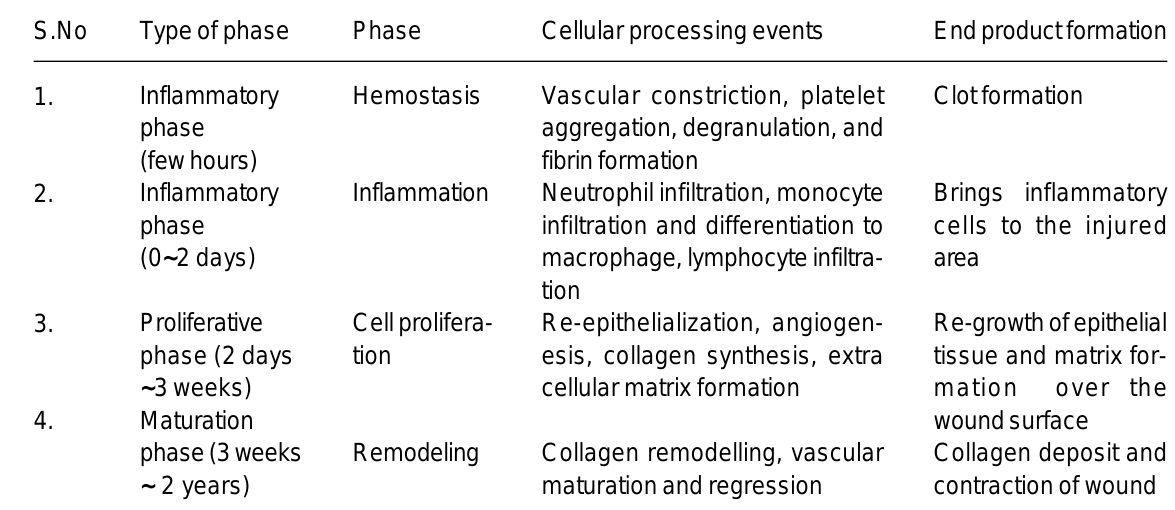
Table 2. Various phases and cellular events that occur during wound healing. S.No